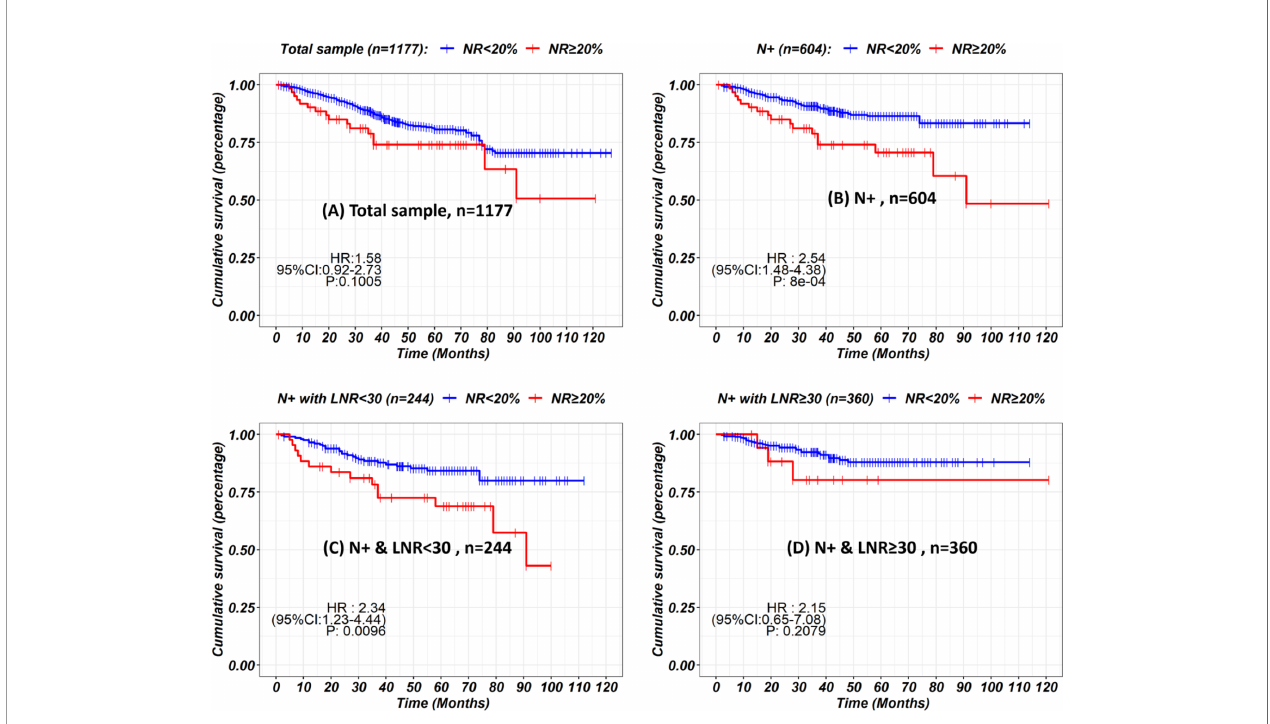
FIGURE 6 | Kaplan-Meier curves showing the impact of node ratio on survival in the total sample (A) , N+ subgroups (B) strati fi ed by LNRs (C, D)